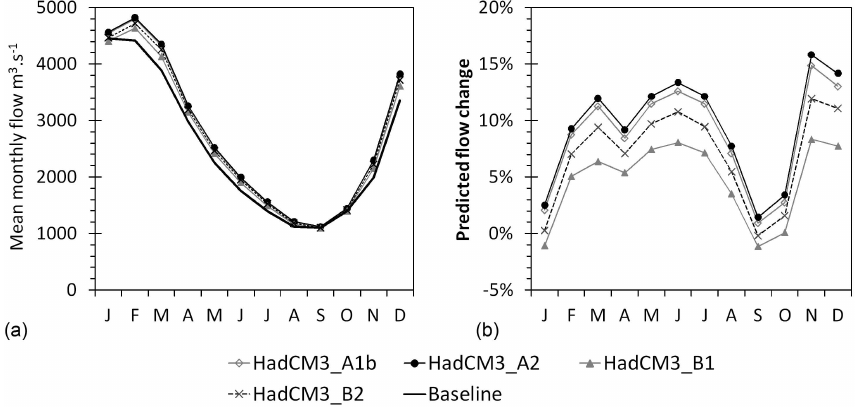
Fig. 3. Projected changes in mean monthly river flow under different SRES emission scenarios using HadCM3 in the Rio Grande basin (a) and relative to the detrended 1961–1990 baseline or control run (b) .